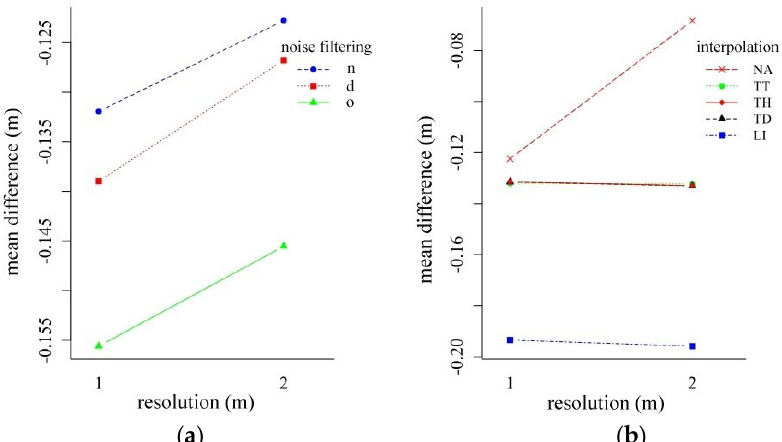
Figure 9. Interaction plot of resolution and noise filtering ( a ) and resolution and interpolation techniques ( b ) (LI: linear interpolation; NA: natural neighbor interpolation; TD: terrain dataset with natural neighbor interpolation; TH: terrain dataset with thinning and natural neighbor interpolation; TT: topo to raster interpolation; d: surface distance-based; n: neighborhood distance-based filtering; o: original point cloud).